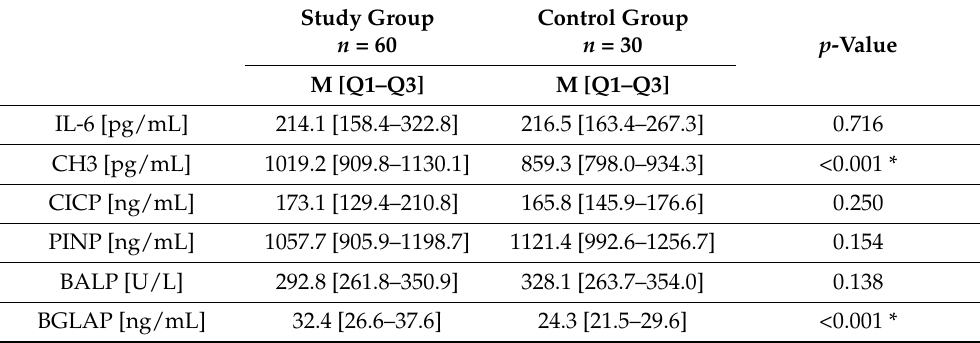
Table 2. Comparison of concentrations of interleukin 6 (IL-6); citrullinated histone CH3 (marker of neutrophil extracellular trap); markers of bone formation (osteocalcin (BGLAP), bone alkaline phosphatase (BALP), N-terminal propeptide of type I procollagen (P1NP)); and the bone resorption marker C-terminal telopeptide of type I collagen (C1CP) between the study group and the control group (median and Q1–Q3).